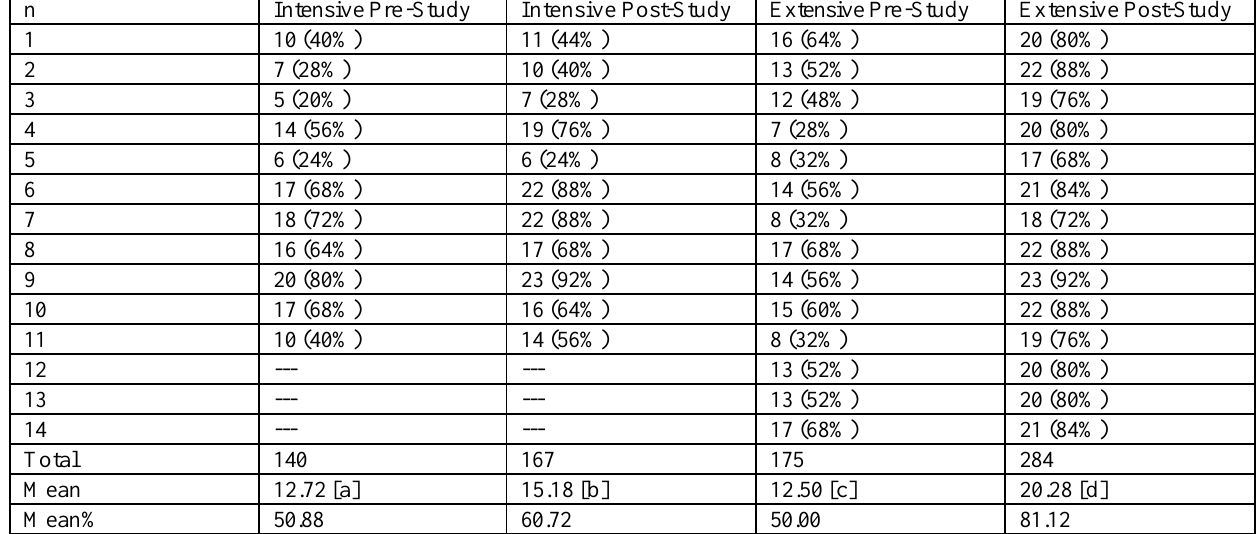
Note: Scores are expressed as totals out of 25 and as percentages.